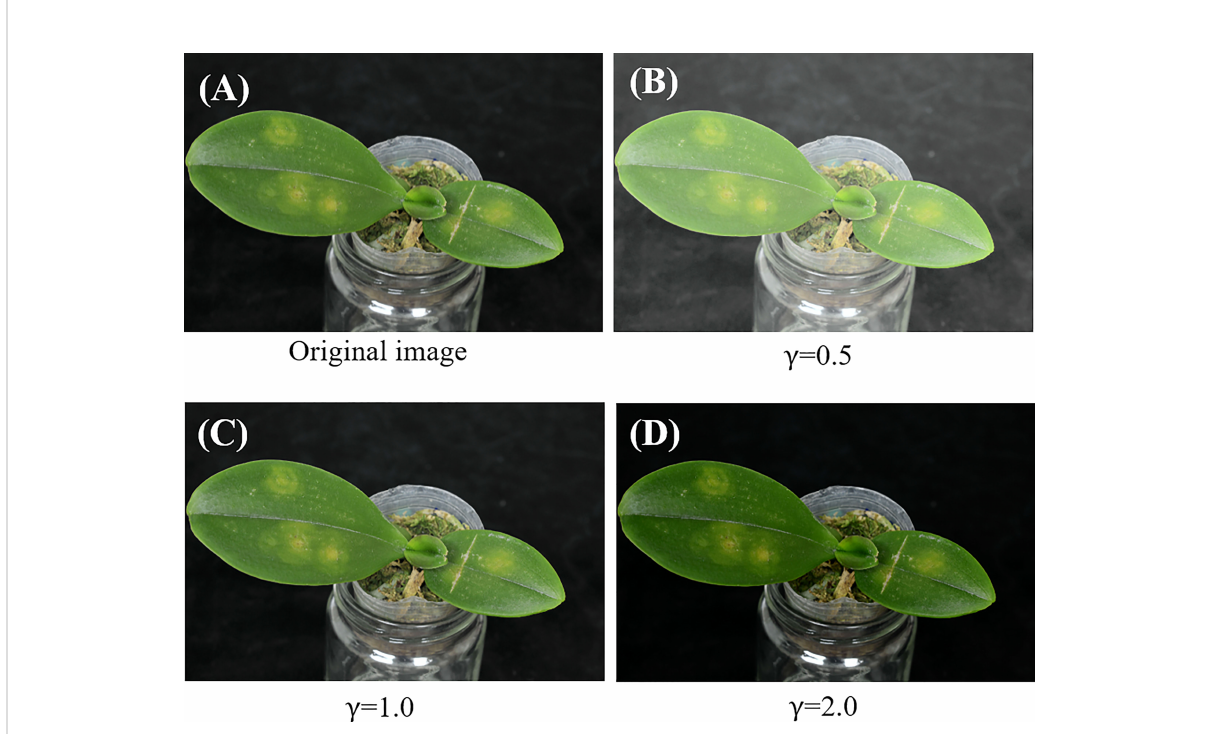
FIGURE 4 (A) An original orchid image and (B-D) images after contrast enhancement with different gamma